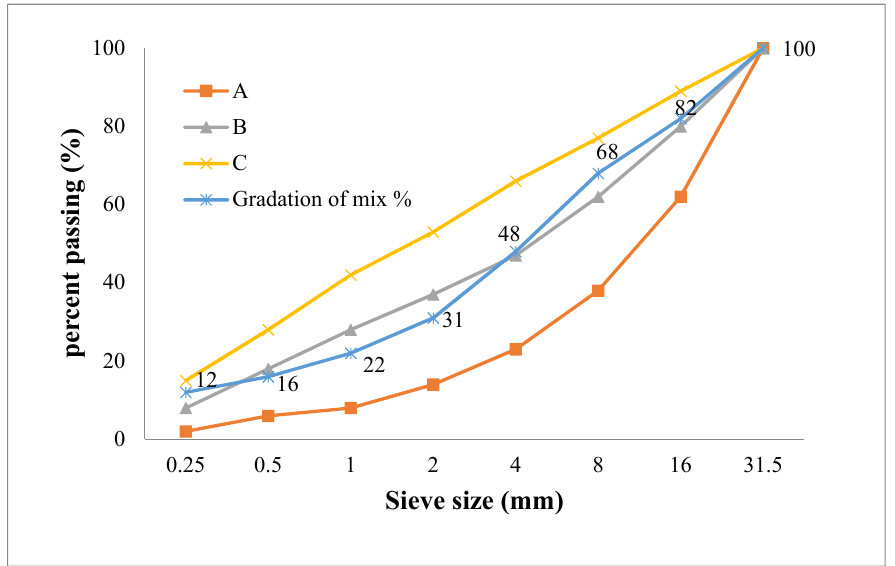
Figure 4. Sieve analysis of the basalt aggregate. Table 4. Some important properties of the aggregates and limit